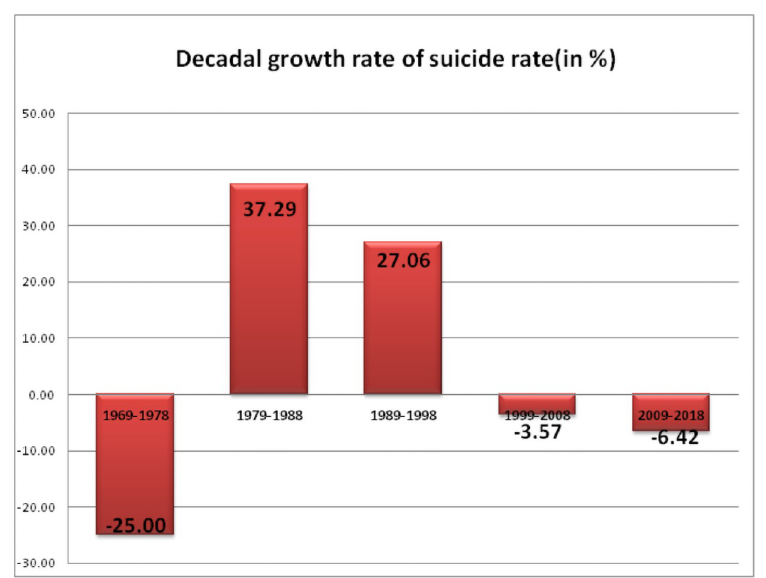
Fig 1. Decadal growth of suicide rate in India (1969–2018).